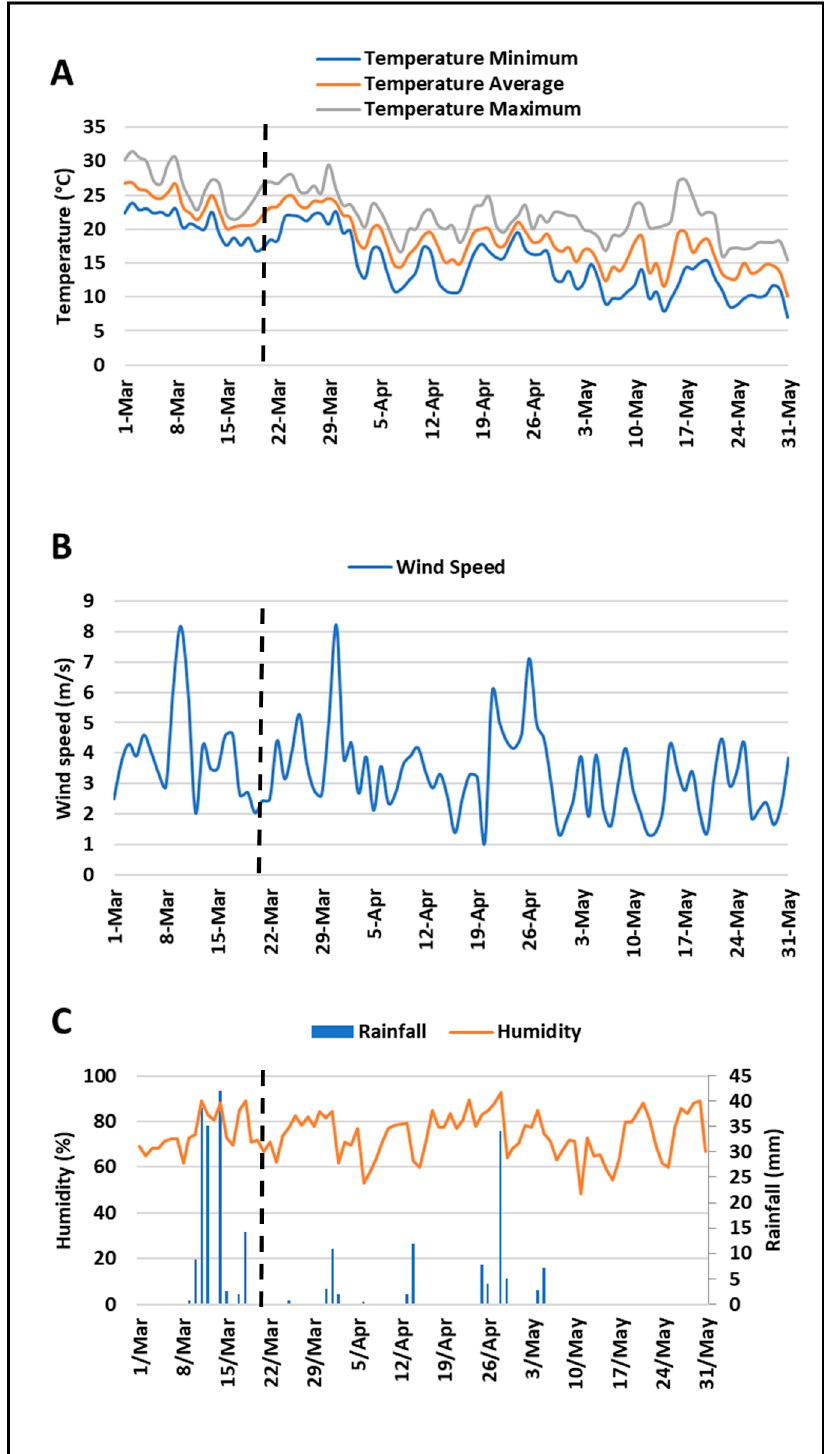
Figure 4. Variation of meteorological conditions observed from 5 March to 31 May for temperature ( A ), wind speed ( B ), and humidity and rainfall ( C ) in CABA. The black dotted line indicates the start of the pandemic lockdown (20 March 2020).